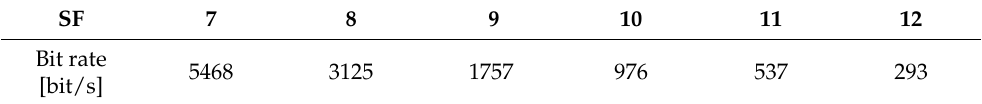
Table 1. Bit rate with BW = 125 kHz and CR =